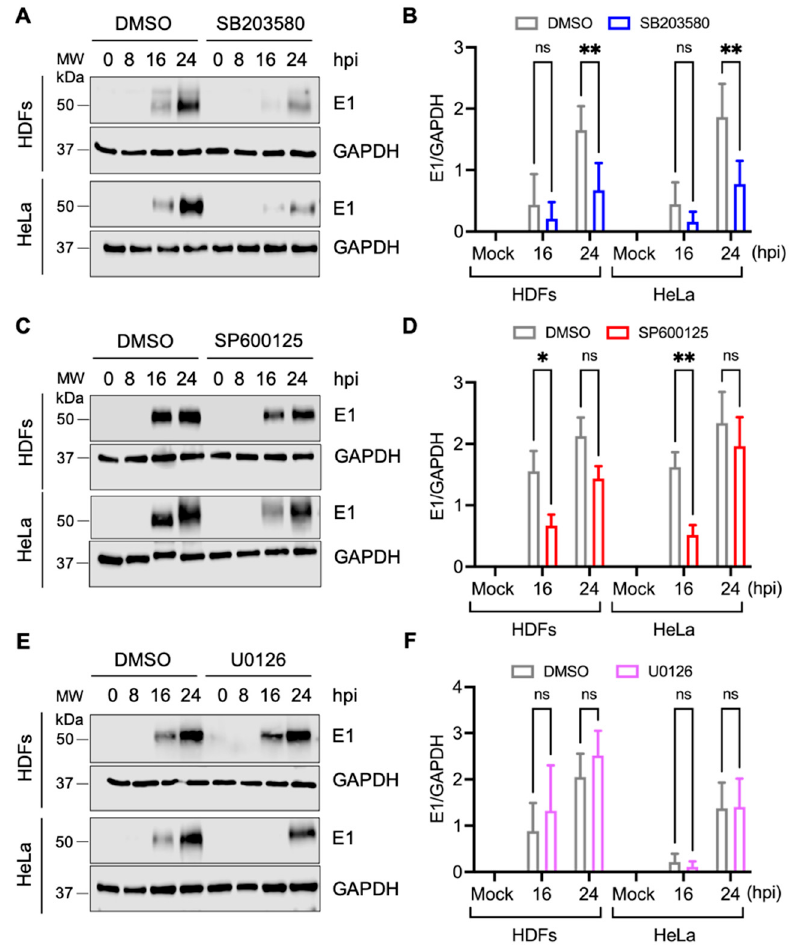
Figure 5. SB203580 disturbs MAYV structural E1 protein expression in both HDFs and HeLa cells. HDFs or HeLa cells were pre-treated with SB203580 ( A ), SP600125 ( C ), or U0126 ( E ) and then infected with MAYV as previously indicated. At different times post-infection, structural E1 viral protein levels were evaluated using immunoblot. GAPDH protein was used as a loading control. MW: molecular weight. kDa: kilodaltons. ( B , D , F ) Densitometric analysis of E1 protein was performed using ImageJ software and normalized with GAPDH protein. Data were analyzed with the Two-way ANOVA test followed by Sidak’s post-test. Statistically significant differences are shown: * p < 0.05; ** p < 0.01 and ns: non-significant.